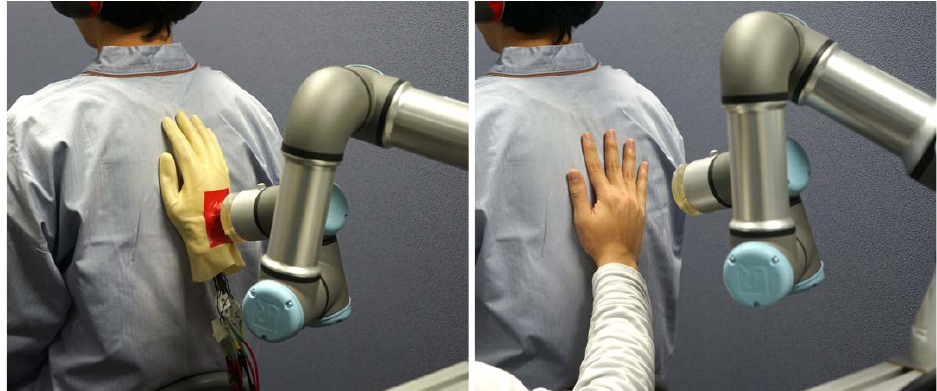
Figure 1. Comparative experimental conditions for the robot stroke motion ( left ) and the human stroke motion ( right